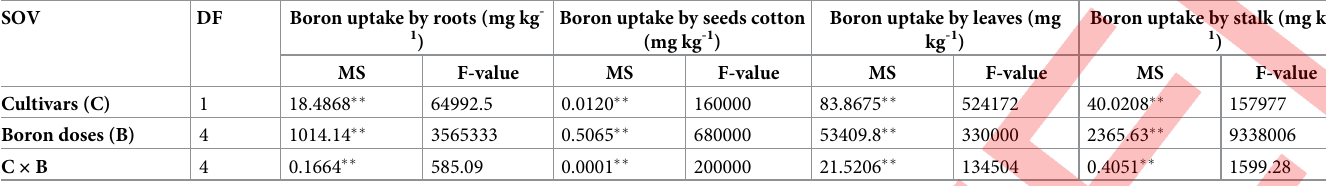
DF = degree of freedom, MS = mean squares, � = significant